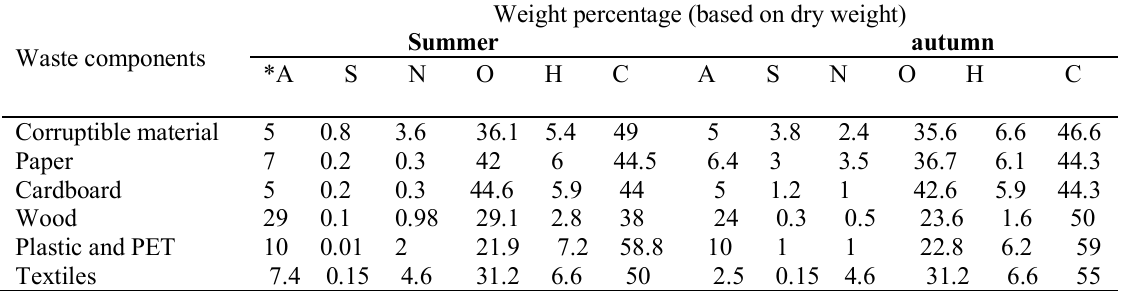
Weight percentage (based on dry weight) Summer